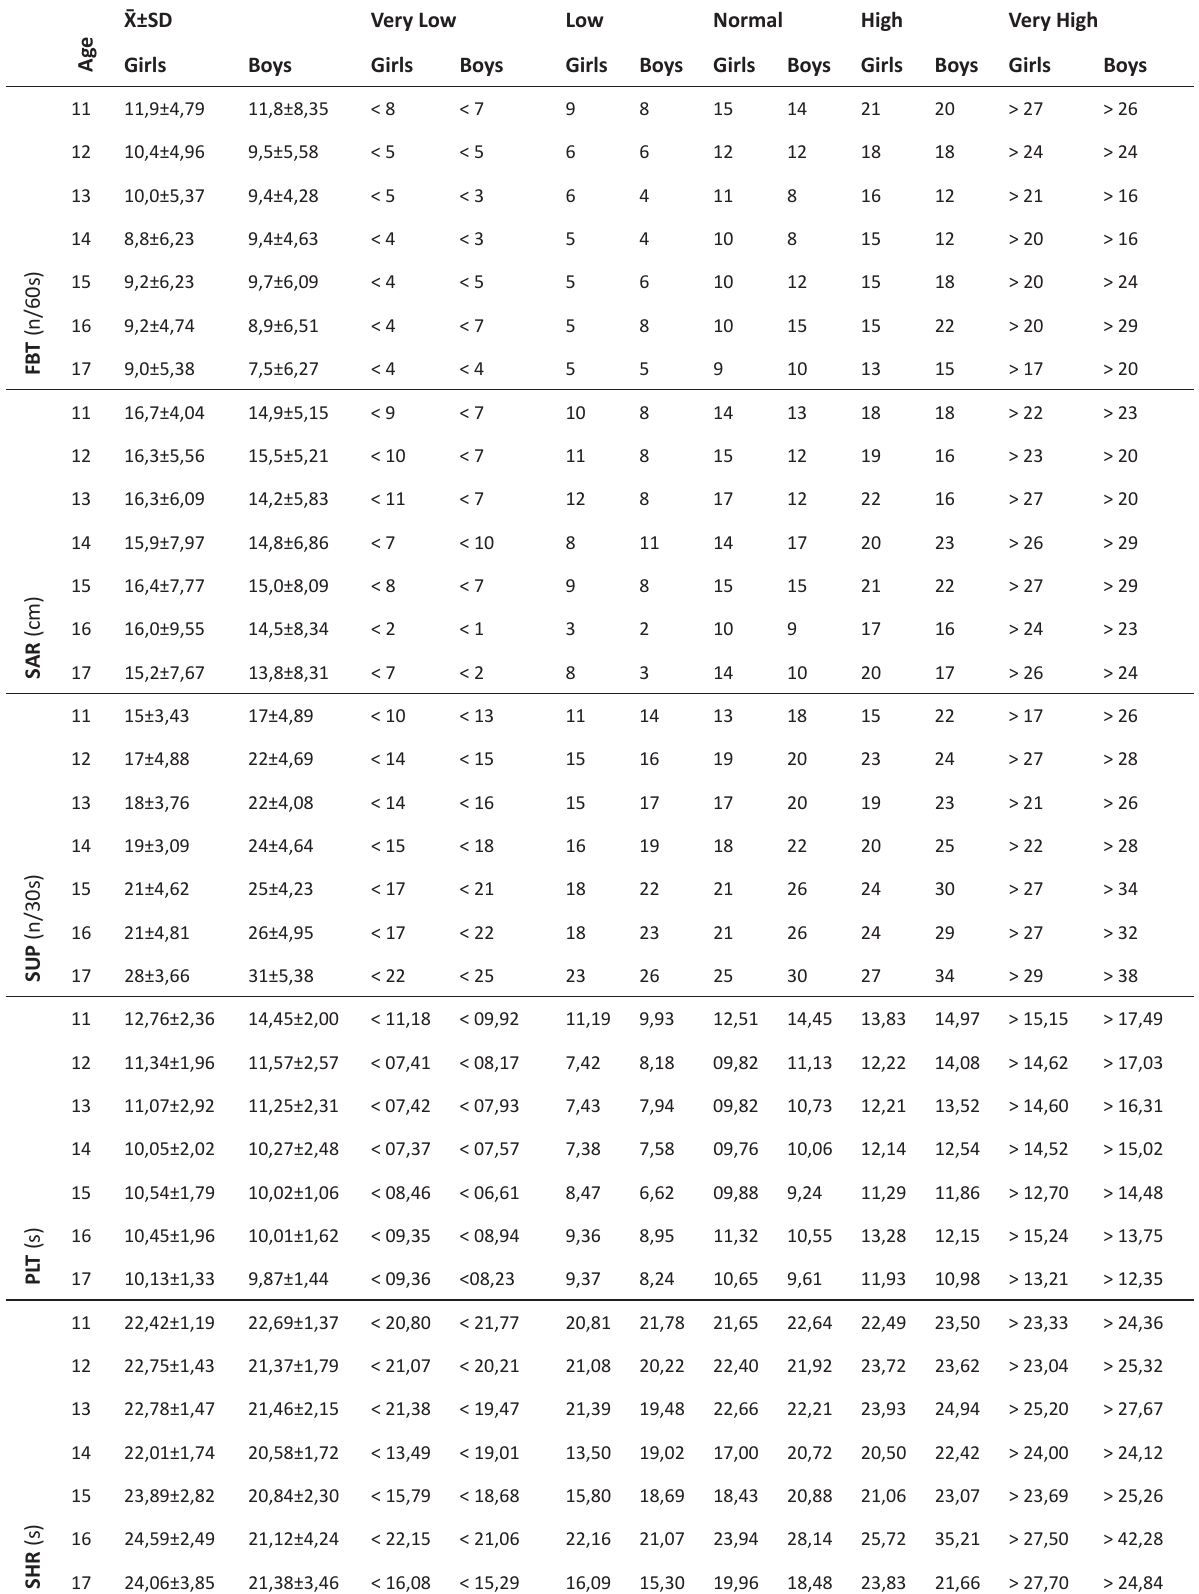
Table 2. Flamingo Balance Test, Sit and Reach, Sit Up, Plate Tapping, Shuttle Run 10x5 Meters Tests Normative Values